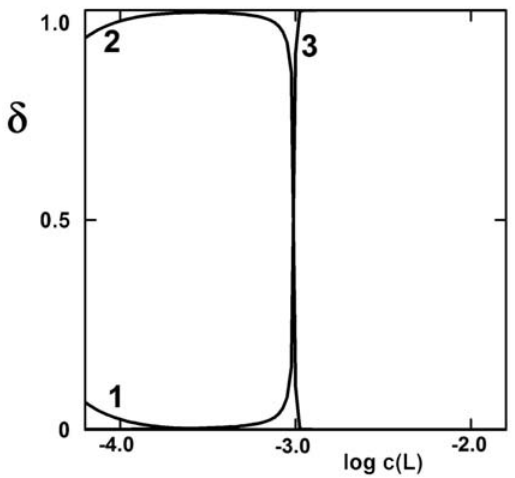
Figure 4. Distribution diagram of europium in the equilibrium ni- trobenzene phase of the water–HNO –Eu 3+ (microamounts)–nitro- 3 benzene– N,N,N’,N’ -tetrabutyl-1,10-phenanthroline-2,9-dicarbo- xamide (L)– H + B – extraction system in the forms of Eu 3+ , EuL 23+ , and EuL 33+ ; c (HNO ) = 0.05 mol/L, c = 0.0025 mol/L. 3 B ]/ c(Eu 3+ ) ]/ c(Eu 3+ ) 1 δ (Eu 3+ ) = [ Eu 3+ , 2 δ( EuL 23+ ) = [ EuL 3+ org 2,org org org